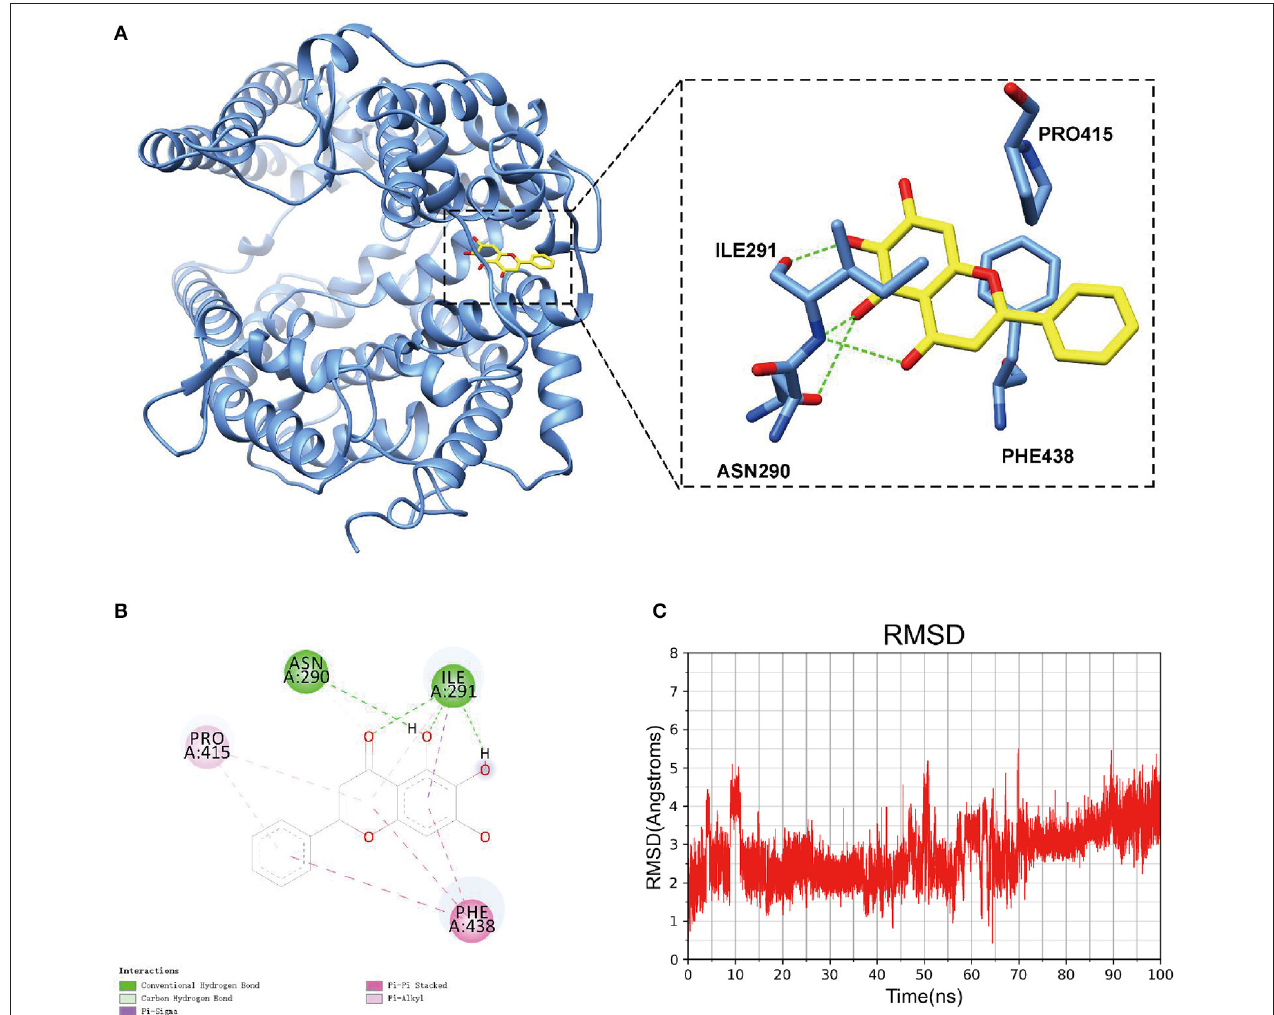
FIGURE 6 | Molecular docking patterns of baicalein and ACE2. (A) The pose of baicalein within the binding site of ACE2. The yellow confirmation was the baicalein, and the green dotted line was the hydrogen bond. (B) 2D-interaction diagram of ACE2 -baicalein interaction. (C) RMSD of baicalein combined with ACE2 for 100